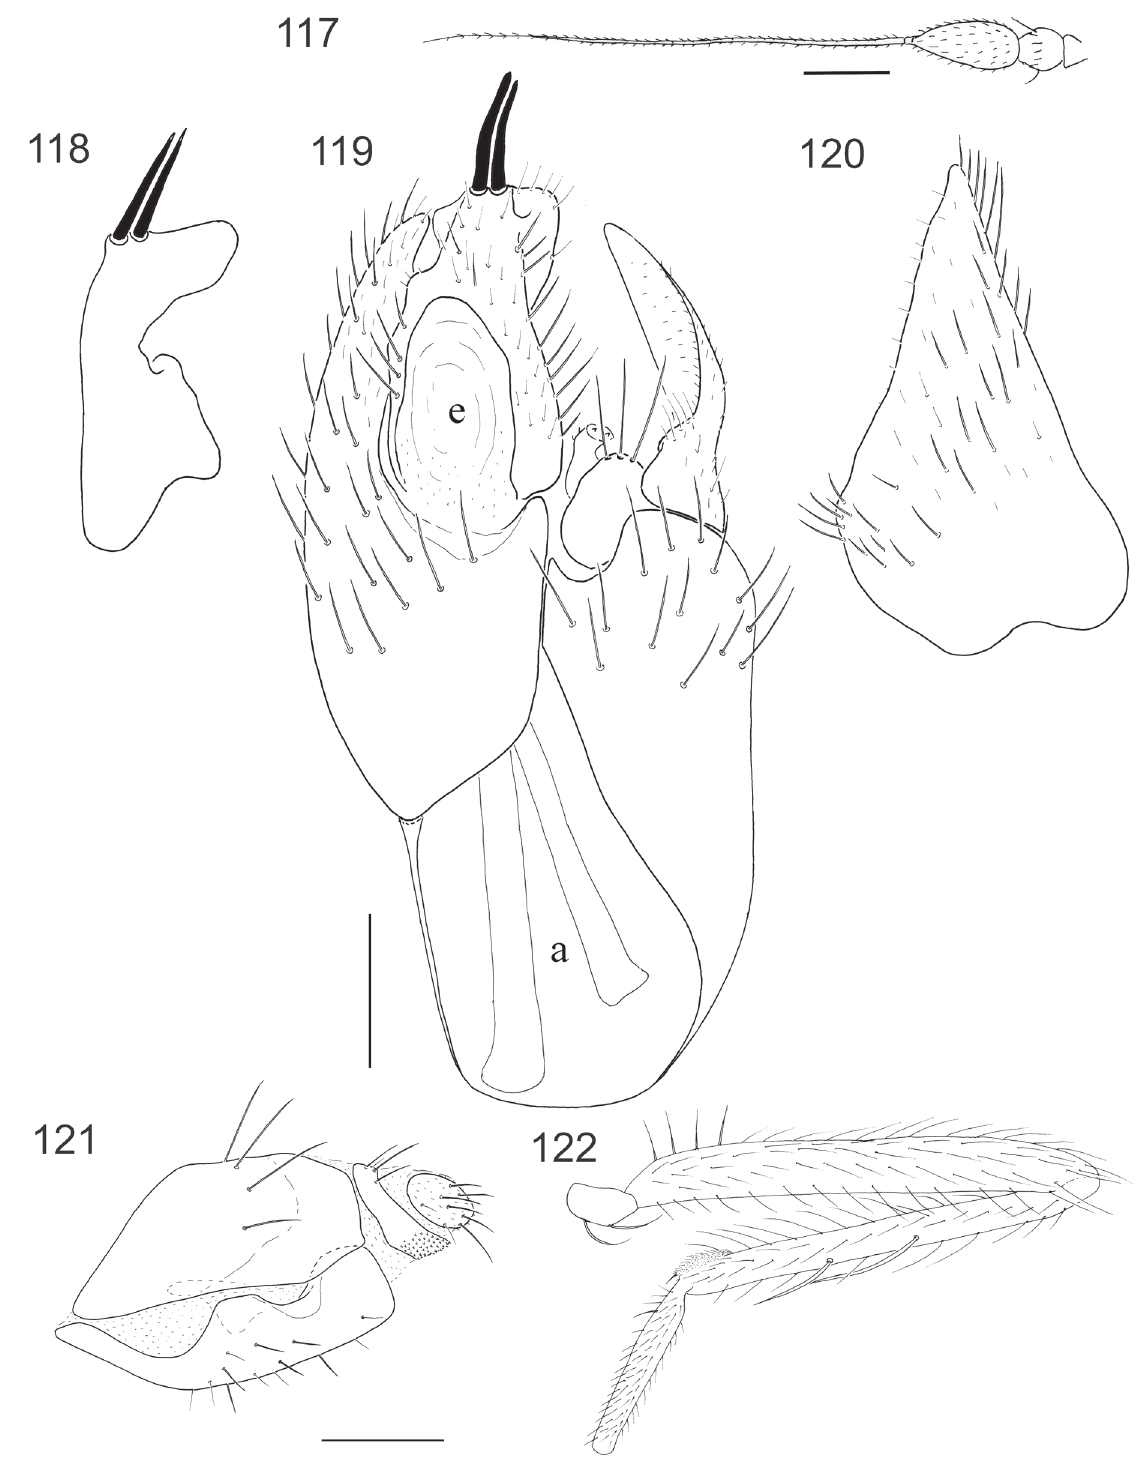
Figs 117-122. Elaphropeza bicaudata (Melander, 1928). 117 . antenna, ♂, lateral view. 118 . cerci, lateral view. 119 . epandrium and cerci, dorsal view. 120 . left surstylus, lateral view. 121 . ♀ ovipositor, lateral view. 122 . hind femur and tibia, ♂, anterior view. Scale bar= 0.1 mm (after Shamshev & Grootaert